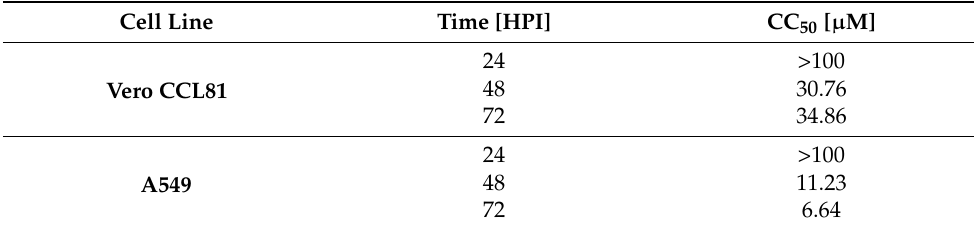
Table 1. Tilorone-induced cytotoxicity in cell